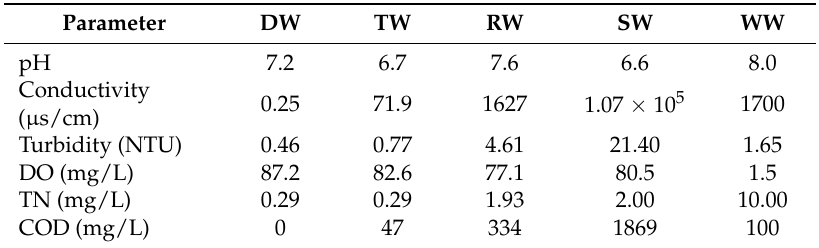
Table 1. Water quality indexes of different water